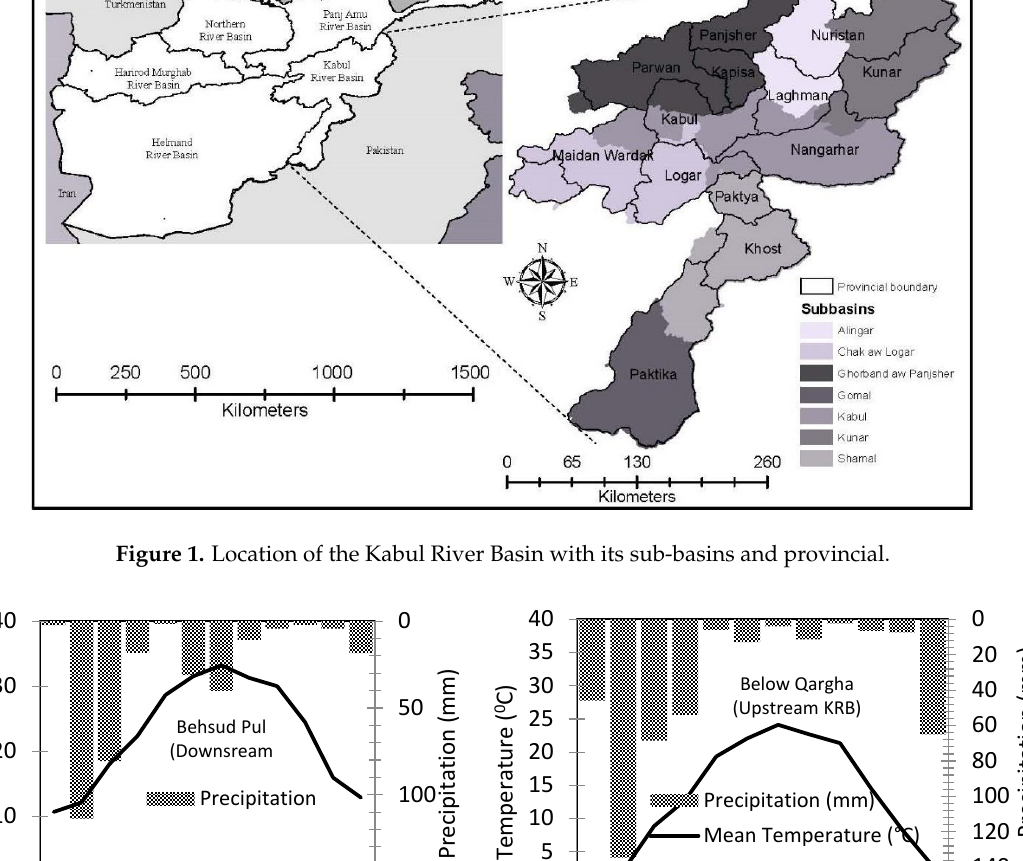
Figure 2. Climatograph of the downstream ( left ) and the central upstream ( right ) of the Kabul River Basin.